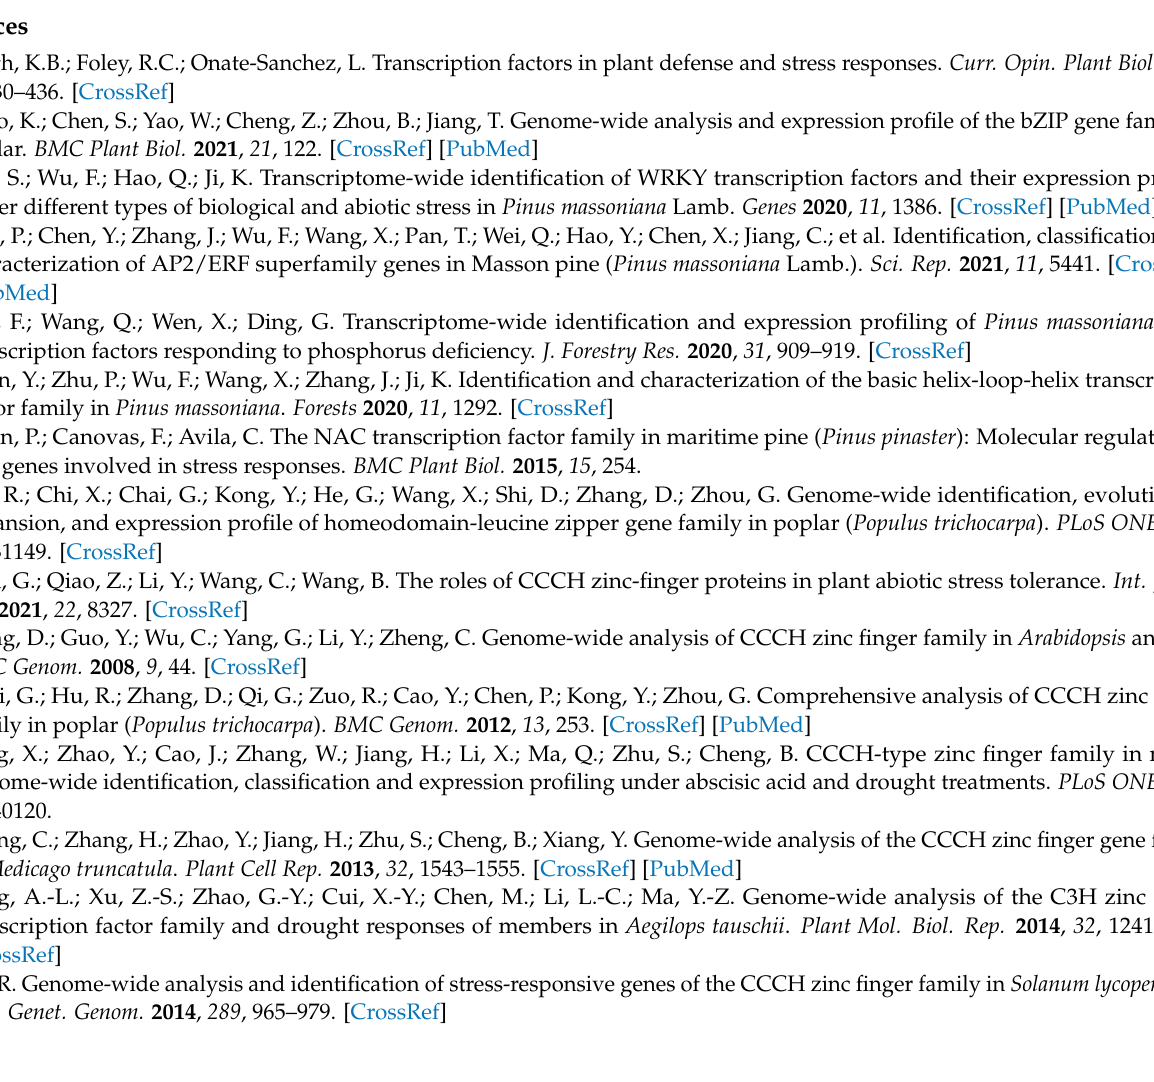
profiles of five genes under abiotic